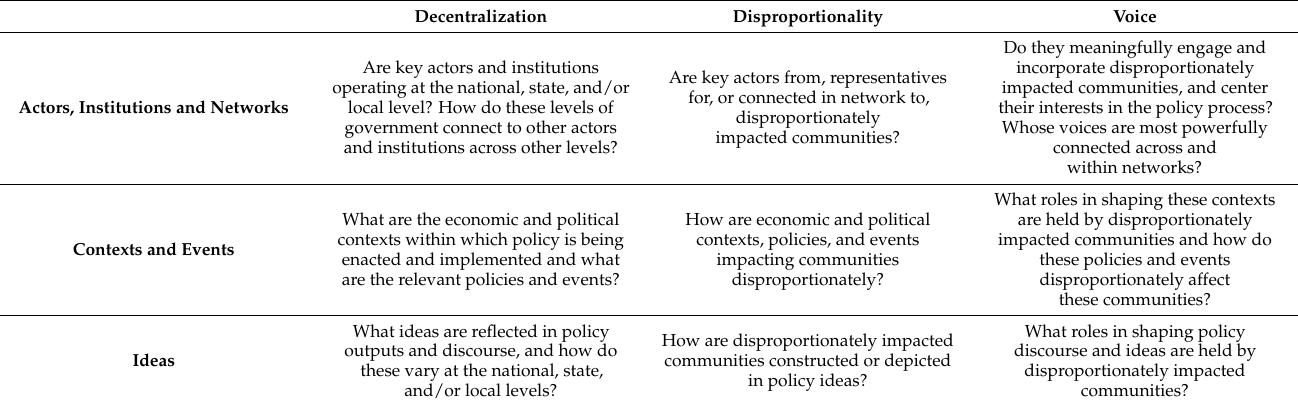
Table 1. Conceptual Framework–A Health Equity Framework (adapted from the REAP Framework). Decentralization